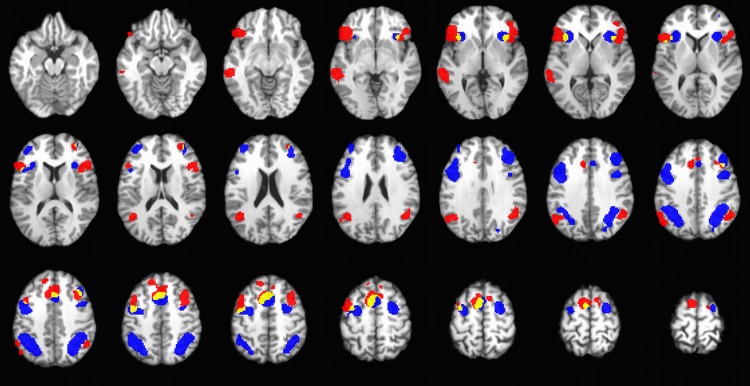
Mosaic view of emotion regulation (red) and working memory (blue) networks.Brain regions recruited by both tasks are depicted in yellow. Maps were thresholded at P < 0.05 and were superimposed on a T1-weighted structural image in axial sections from z = -8 mm to z = 61 mm, with a between-slice gap of 3 mm.